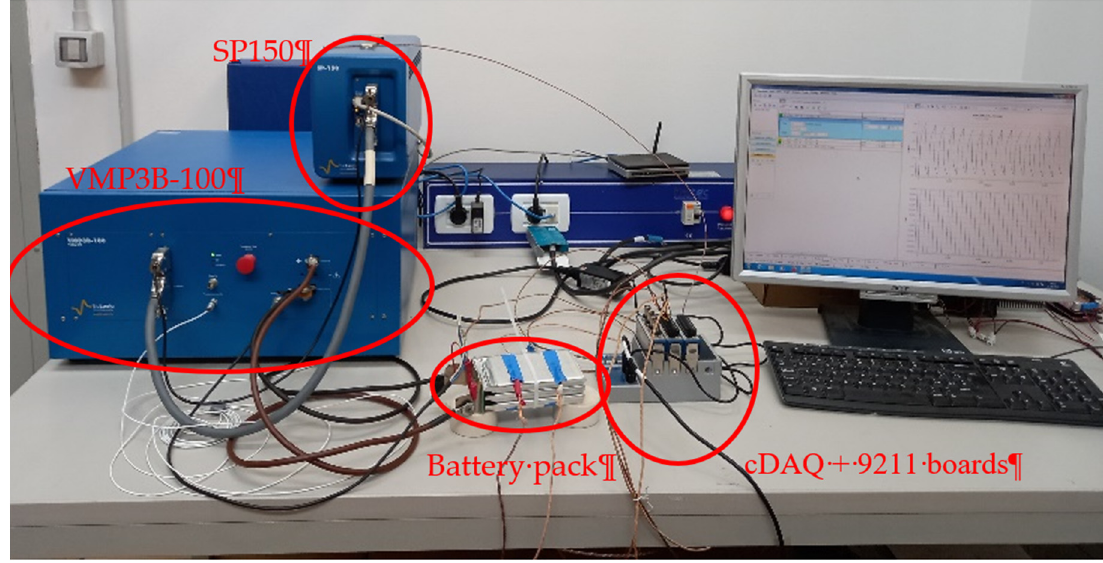
Table 2. Instrumentation accuracy.